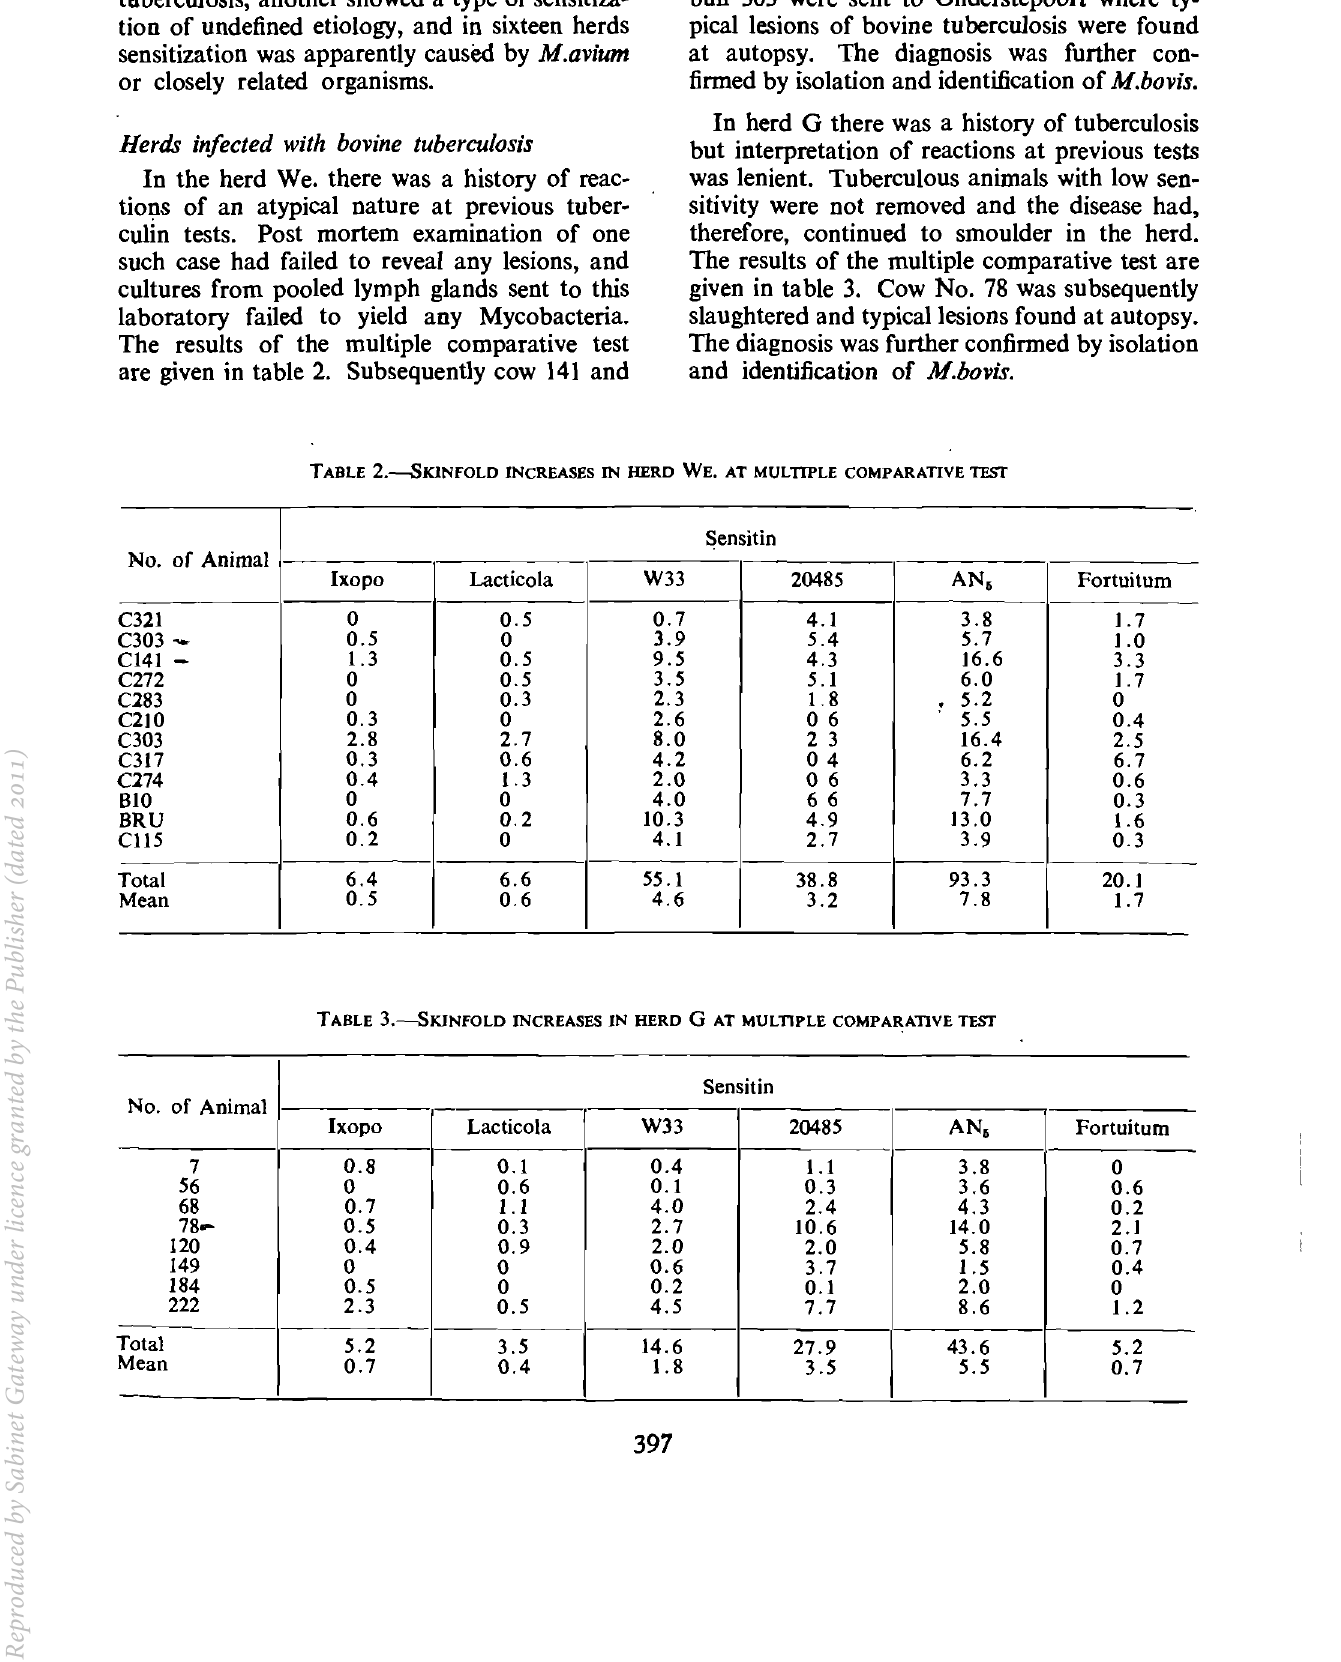
TABLE 2.---SKlNfOLD INCREASES IN HERD WE. AT MULTIPLE COMPARATIVE TEST